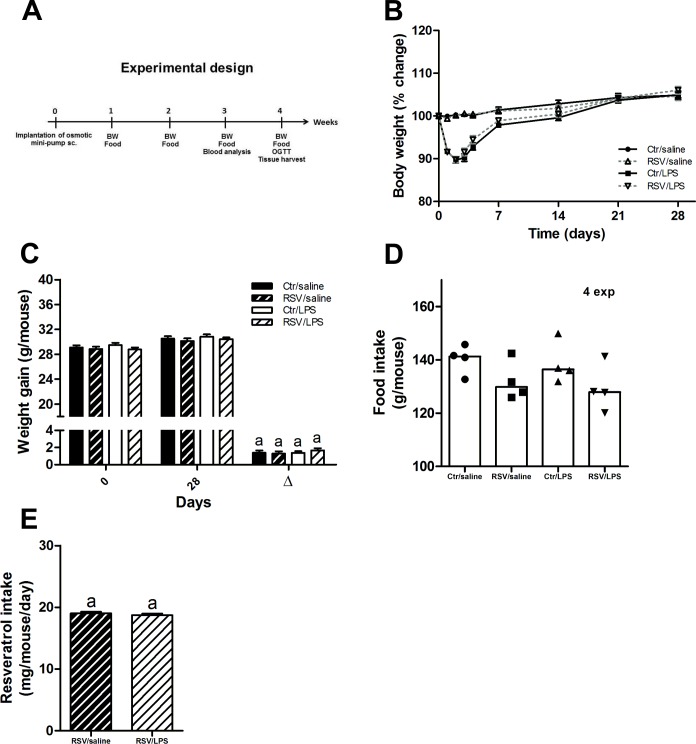
Body weight and food intake.(A) Schematic overview of the research design. (B) Body weight during the course of the experiment in mice treated with control diet and saline (Ctr/saline), resveratrol diet and saline (RSV/saline), control diet and LPS (Ctr/LPS) and resveratrol and LPS (RSV/LPS) (n = 28–29 per group). (C) Total weight gain expressed in g/mouse after 28 days of treatment (n = 28–29 per group). (D) The total food intake during the experimental period of 28 days in four independent experiments. (E) Average daily resveratrol consumption. Data are presented as means ± SEM. Means with different superscript letters are significantly different at P < 0.05 according to post-hoc ANOVA or unpaired t-test.